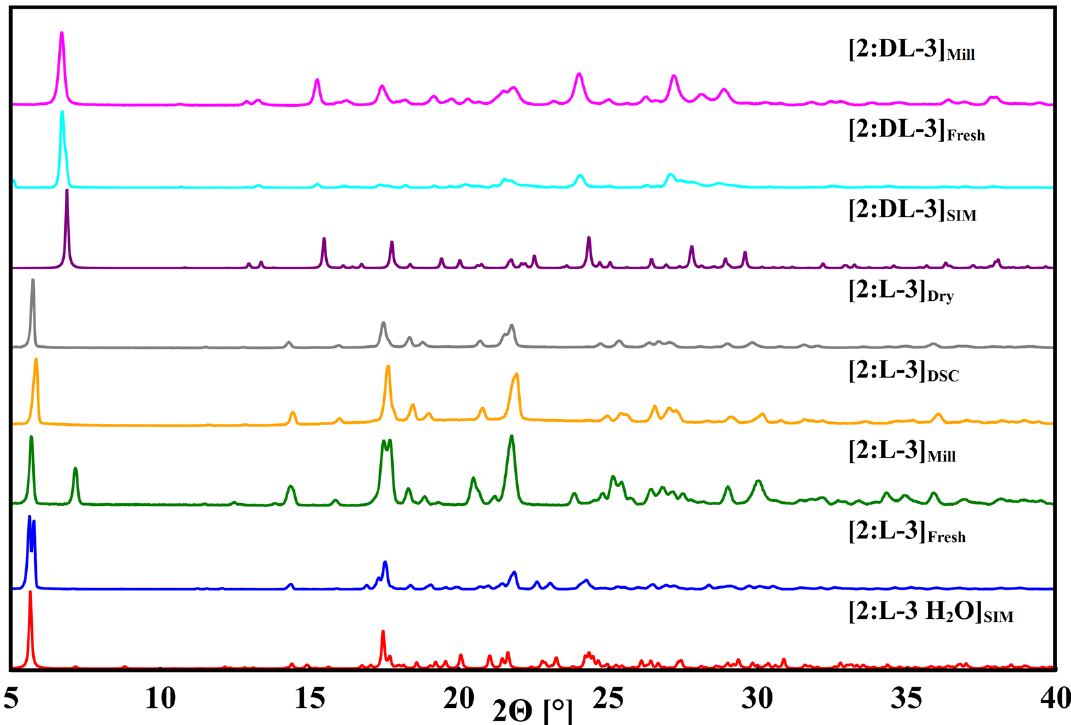
Figure 9. Selected powder patterns received from crystallization experiments involving Phenibut and tartaric acid in a range 2–40 ◦ 2 Θ are compared to the simulated 2:L − 3 • H 2 O (red) and anhydrous 2 : DL − 3 (purple) pattern: (blue) freshly prepared sample with L − tartaric acid from aqueous solution; (green) methanol-assisted co-milling sample of Phenibut and L − tartaric acid; (orange) 2 : L − 3 • H 2 O sample from aqueous solution after heating to 120 ◦ C in a DSC chamber; (grey) 2 : L − 3 • H 2 O after vacuum drying; (cyan) fresh 2 : DL − 3 sample from aqueous solution crystallization; (magenta)